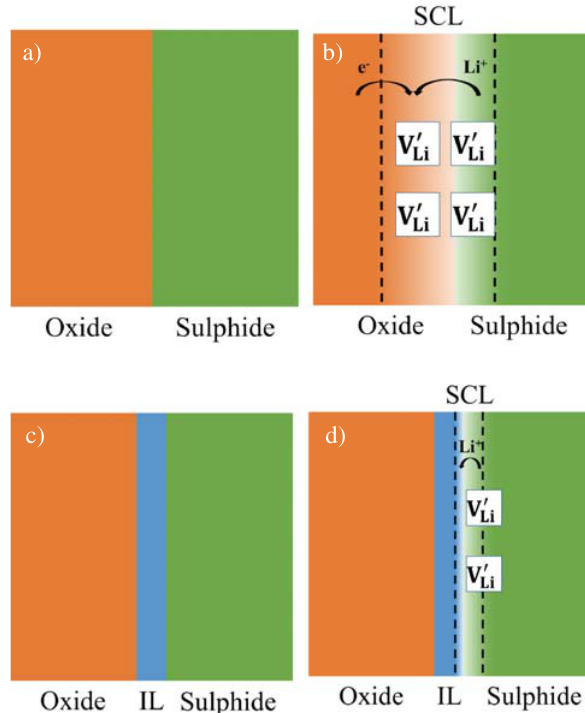
Fig. 3. (a) The two-phase boundary of oxide and sulphide; (b) The defect chemistry situation after the formation of SCL; (c) Introduction of ionic-conducting intermediate la- yer (IL) between the two phases; (d) The defect chemistry situation after the introduction of the